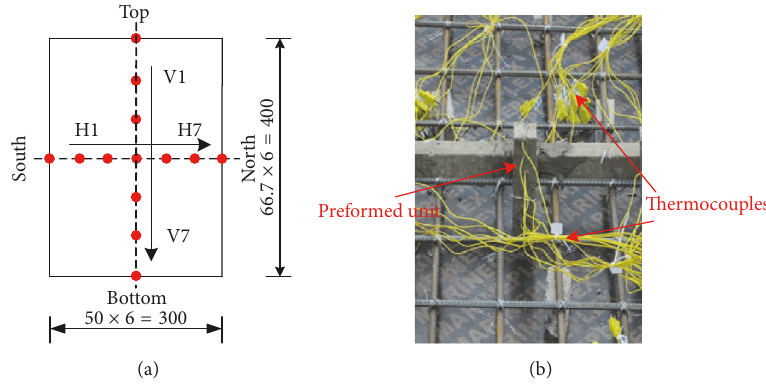
Figure 3: Arrangement and positioning of thermocouples. (a) Arrangement; (b) positioning.